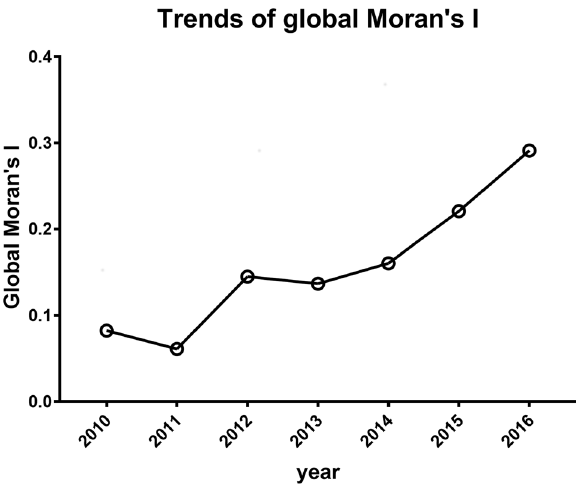
Figure 2. Changing pattern of Global Moran’s I statistics for seven years in Ohio;